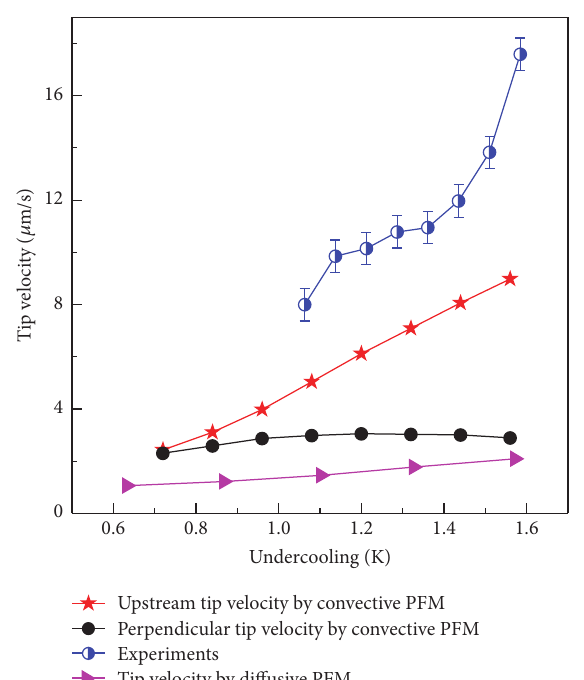
Figure 9: Comparison between experiment and phase-field sim- ulation in the presence of natural convection. The phase-field simulation result without natural convection is also